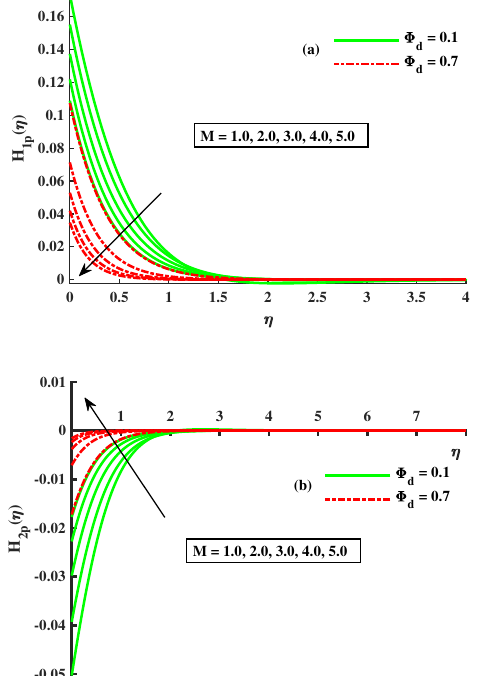
Figure 3. Influence of φ d & M on ( a ) H 1 p ( η ) & ( b ) H 2 p ( η )